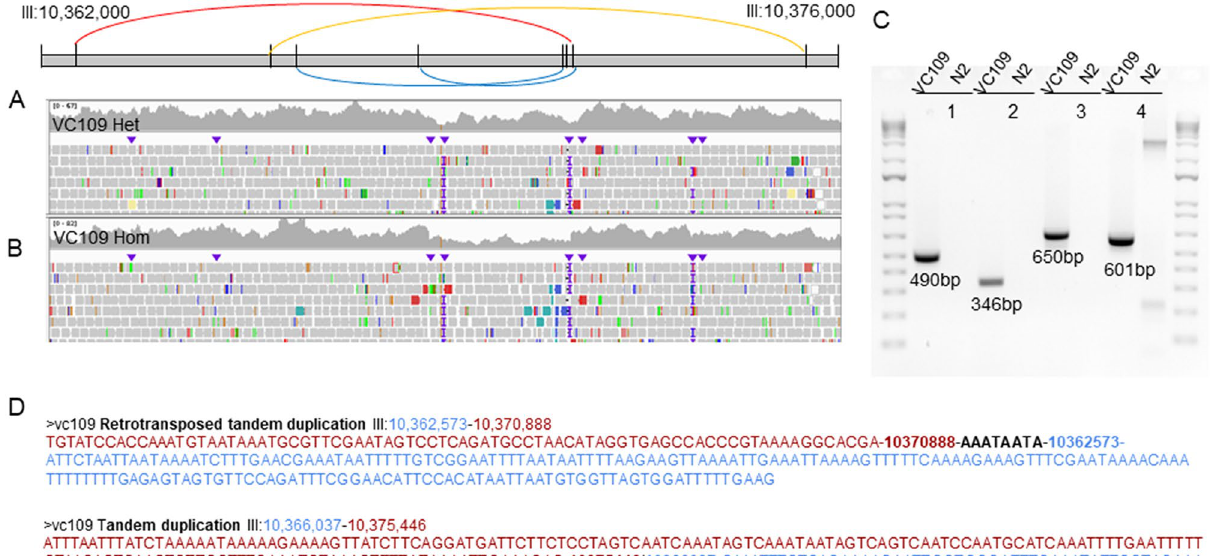
Figure 4. Complex rearrangement in VC109 on LGIII. ( A ) Schematic representation of the complex rearrangement combining one inverted tandem duplication (red), one direct tandem duplication (orange), and two deletions (blue) along LGIII around 10 Mb. ( B ) IGV screenshot for the region overlapped by the complex rearrangements. ( C ) PCR gels. 1 = Inverted tandem duplication III:10,362,573–10,370,888; 2 = Deletion III:10,366,492–10,370,879; 3 = Direct tandem duplication III:10,366,037–10,375,446; 4 = Deletion III:10,368,666– 10,371,166. ( D ) Sequences obtained with Sanger sequencing displaying regions surrounding